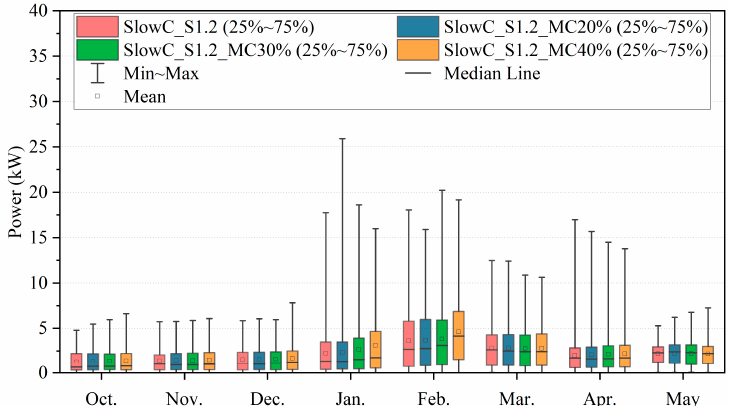
Figure 14. Values of P + flexibility factor for each month during the heating season (14 October–7 May).